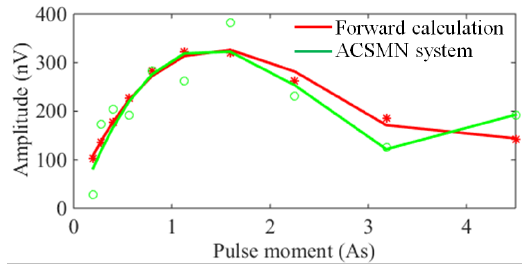
Figure 17. E 0 vs. q curves extracted by the forward calculation and the CSMN system.